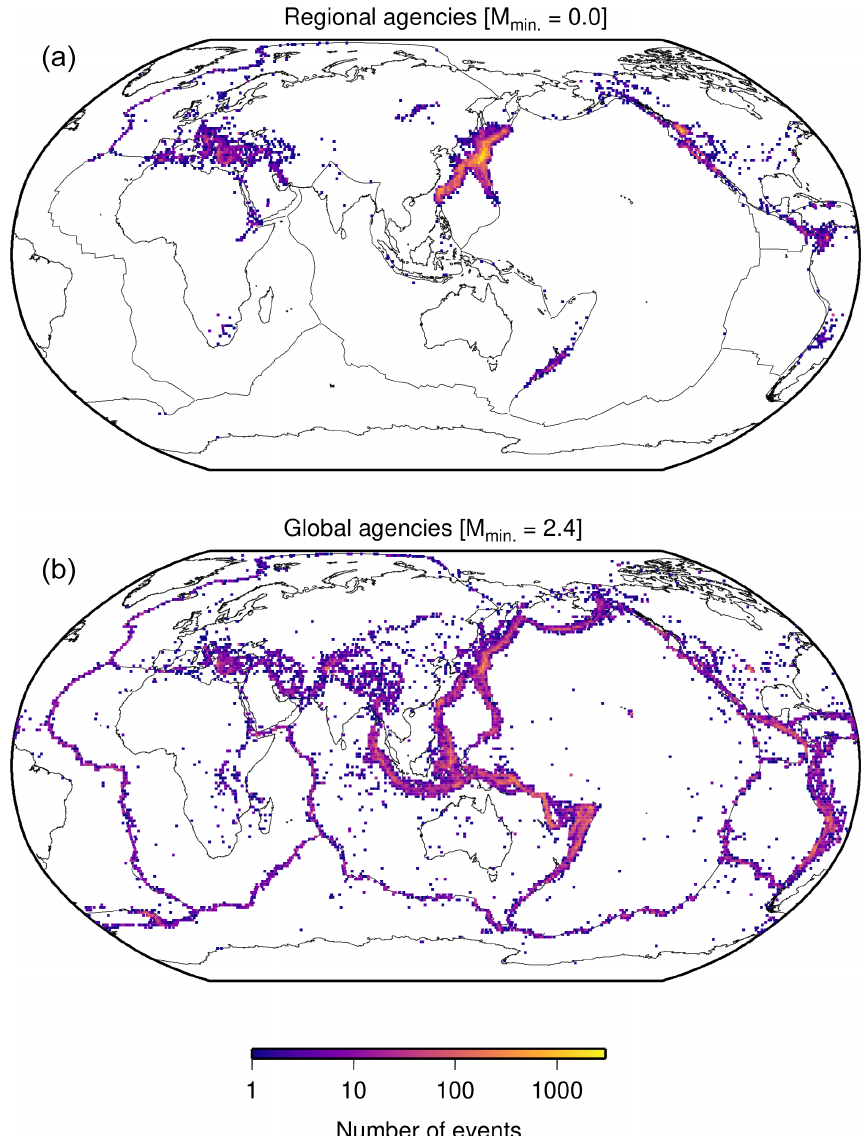
Figure 3. Global maps showing the number of events with at least one source mechanism reported in the ISC Bulletin for the time period from January 1964 to December 2018, in a 1 ◦ by 1 ◦ grid, for mechanism solutions reported by local and regional agencies (a) , and global agencies ( b , (GCMT, HRVD, IPGP, ISC, MOS, NEIC, NEIS)). The minimum magnitude ( M min . ) following the scheme described in Di Giacomo and Storchak (2015) is shown on top of each